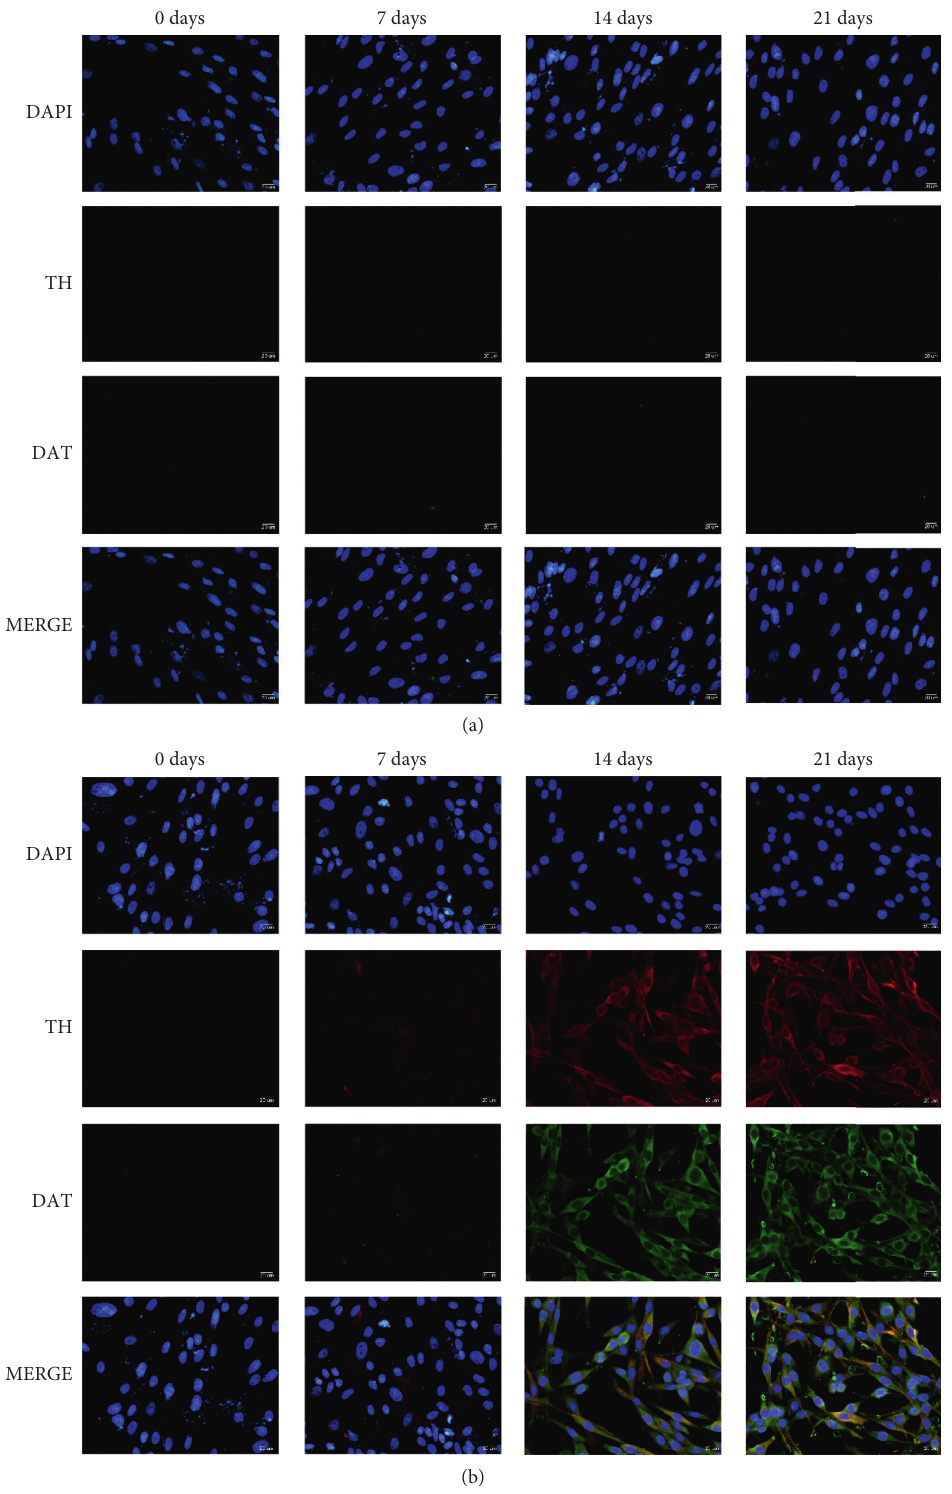
Figure 3: Immunofluorescence analysis showing TH (red fluorescence) and DAT (green fluorescence) expression of the transfection group was increased after 14 and 21 days of induction compared to the corresponding levels in the control group. Scale bar � 20 μ m. TH, tyrosine hydroxylase; DAT, dopamine